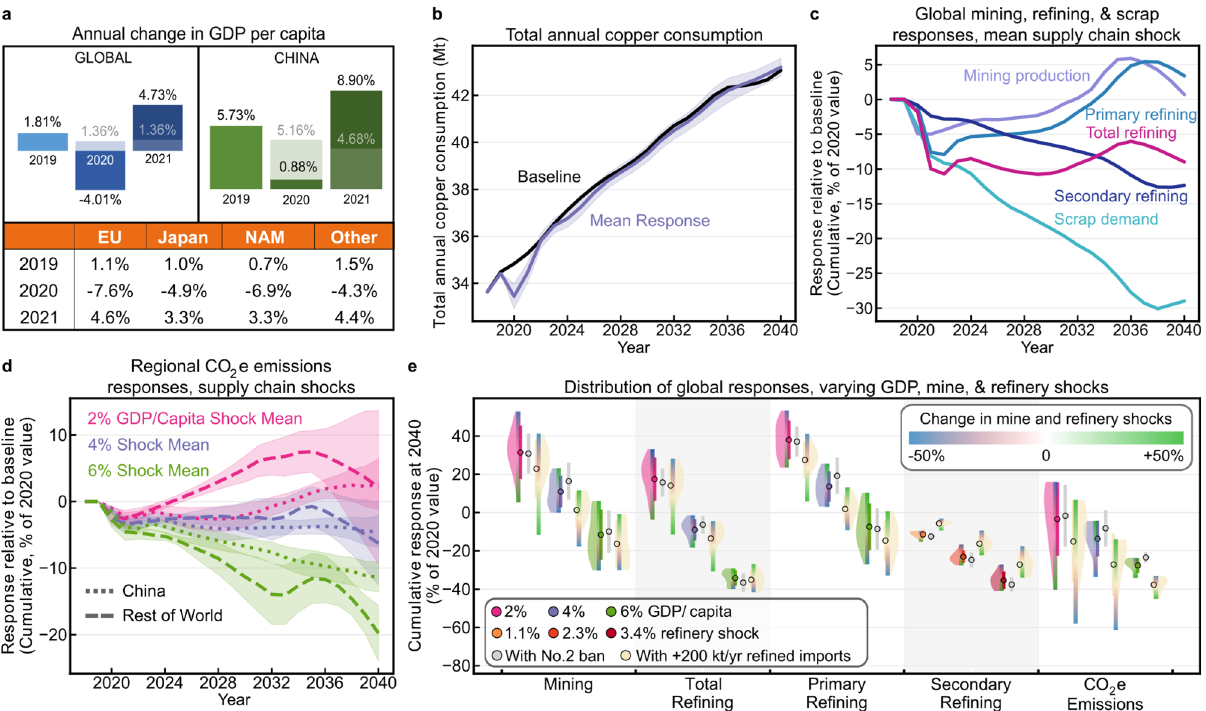
Fig. 5 System response to COVID-19 scenarios and supply chain disruption sensitivities. a The annual changes in gross domestic product (GDP) per capita for 2019, 2020, and 2021 used in the COVID-19 response scenario, using values adapted from annual change in GDP from the International Monetary Fund. Baseline values for China and global are shown in gray, while the table shows projections for the European Union (EU), Japan, North America (NAM), and other. b Global annual copper consumption including alloyed and unalloyed re fi ned and scrap copper consumption for baseline and the mean COVID-19 scenario response. Shaded areas represent one standard deviation from the mean. c Cumulative global secondary re fi ning, scrap demand, mining production, total re fi ning, and primary re fi ning responses relative to baseline as a percent of the 2020 value, labeled from top to bottom using 2040 as reference. Standard deviations are not shown for clarity, but are included in the data repository described below. d Cumulative CO 2 e emission responses relative to baseline for China and RoW as a percentage of the 2020 global value. Shaded areas represent one standard deviation from the mean. e Violin plot showing the distribution of global responses for COVID-19 response scenarios using 2, 4, and 6% declines in global GDP per capita from 2019 to 2020, with mean values shown as same colored points. Gray points and bars represent the mean system response and standard deviation when the No.2 scrap China solid waste import ban is simulated simultaneous with the COVID-19 shocks, and light yellow incorporates the 200 kt/year increase in China ’ s re fi ned copper imports alongside the No.2 ban. Green and blue color bar overlays indicate the magnitude of the mine and re fi nery system shocks. For secondary re fi ning, GDP changes produced near-equal violin plots and here the data are grouped by the three levels of re fi nery shock instead, with the color bars representing changes in mine and GDP/capita shocks. Underlying data for this fi gure may be found in a data repository